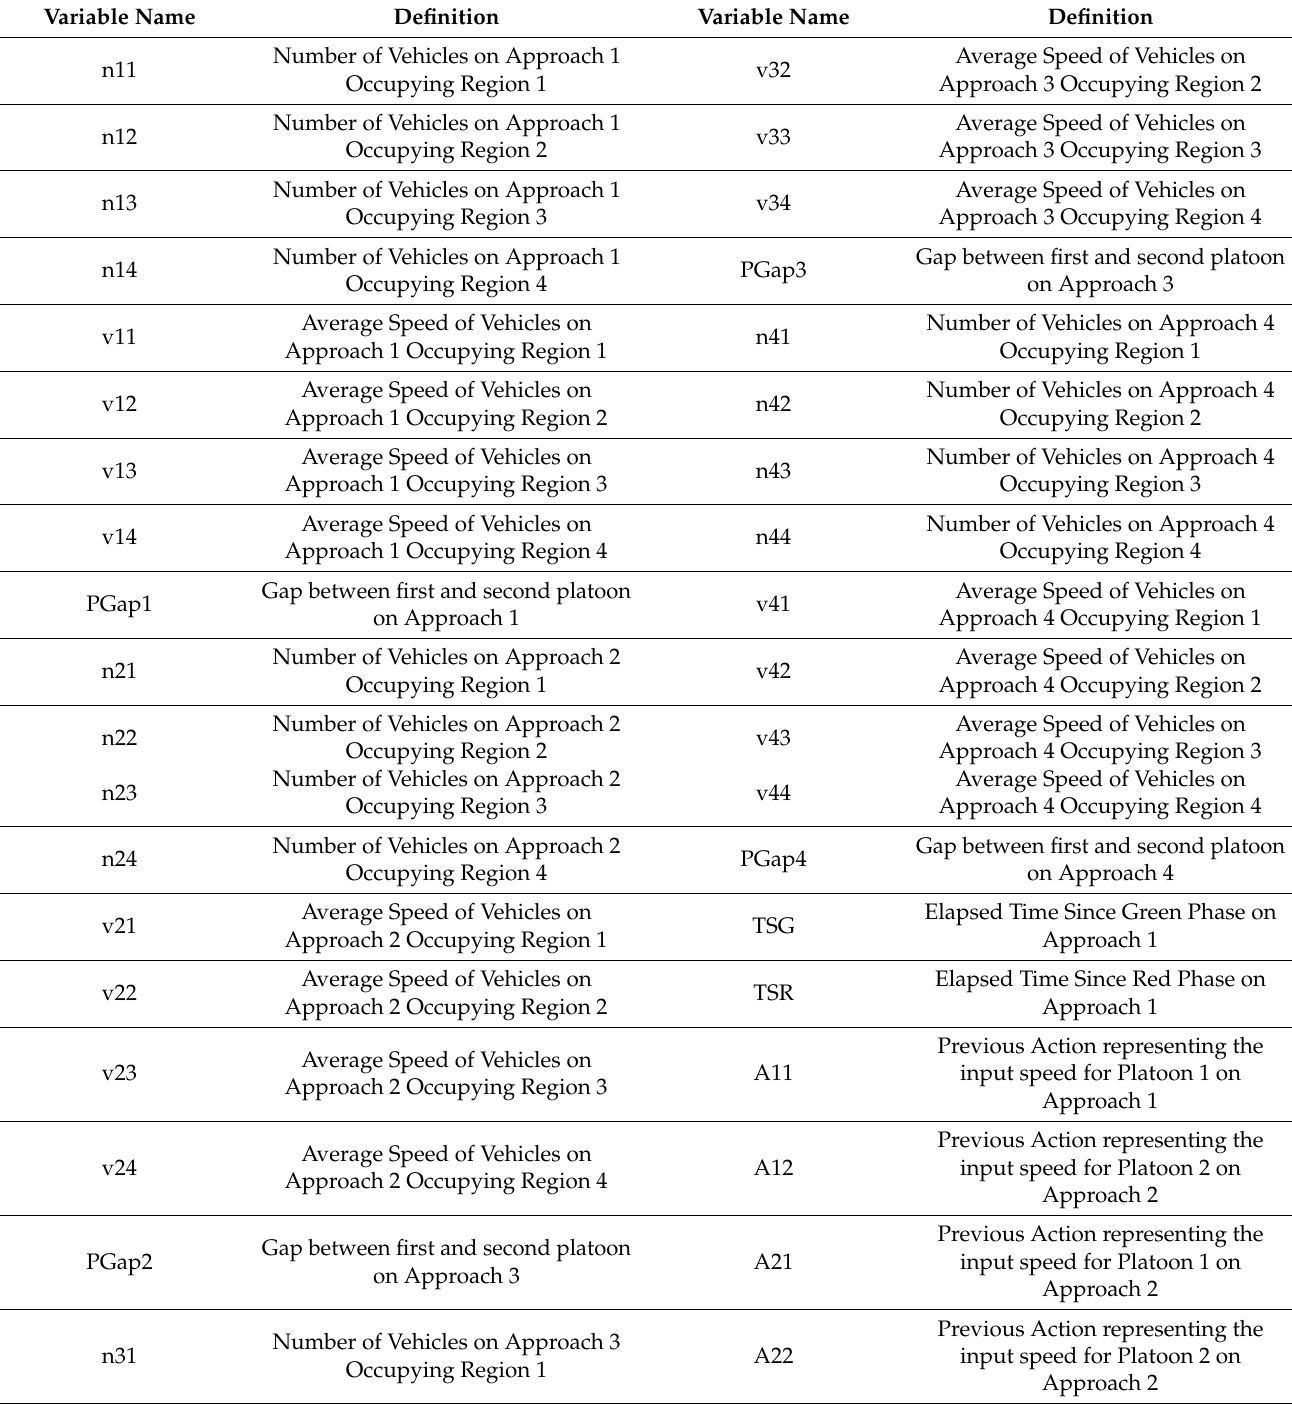
Table 1. Relevant input variables considered by the reinforcement learning